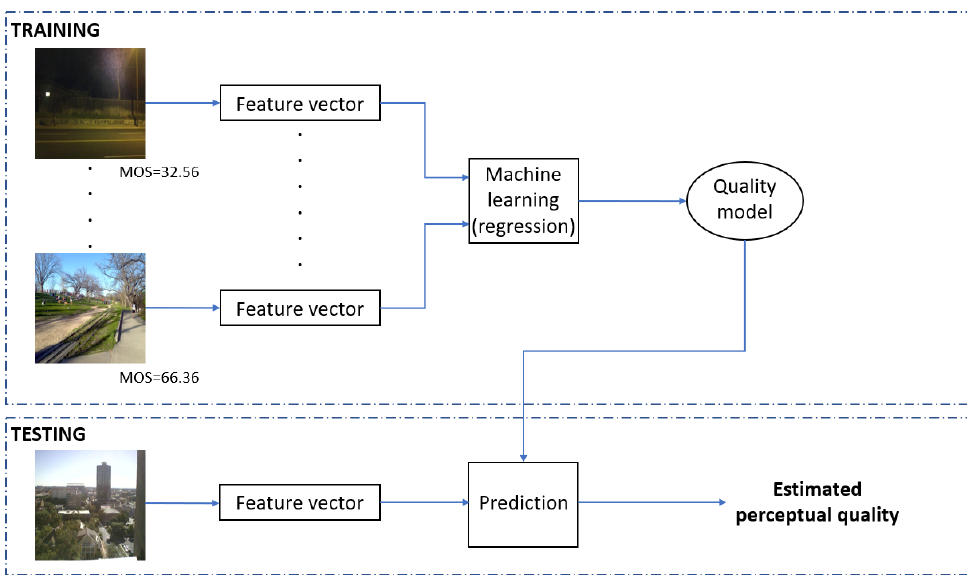
Figure 2. Workflow of the proposed NR-IQA